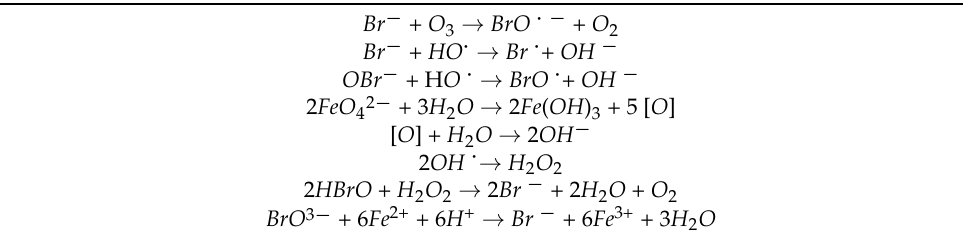
Table 8. The mechanism of inhibiting bromination in the ferrate/ozonation processes